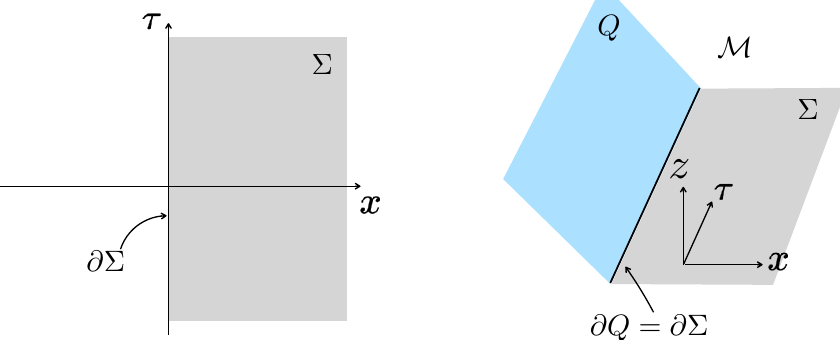
Figure 3 . BCFT defined on a half plane (left) and its gravity dual